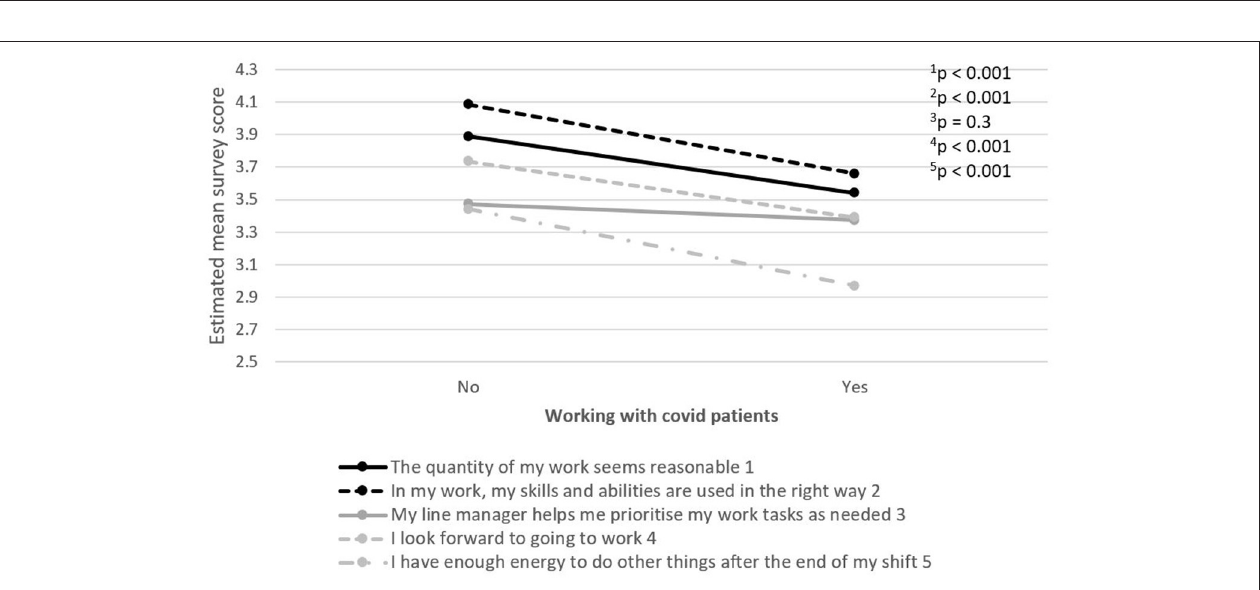
FIGURE 3 | The overall effects of the COVID-19 pandemic on working conditions and recovery stratified for occupational status compared to the situation before the pandemic i.e., a negative result indicates a more negative perception of work environment and recovery during the pandemic, and vice versa. The overall effect size should be related to the item’s response scale ranging between 1 (strongly disagree) and 5 (strongly agree).